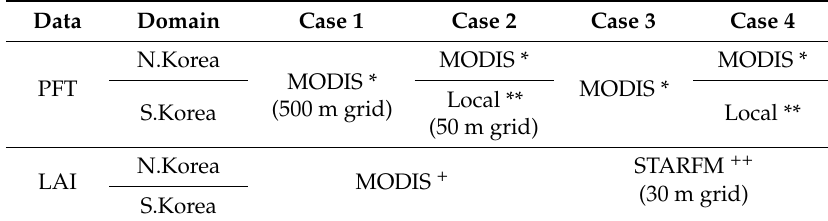
Table 2. Experiment